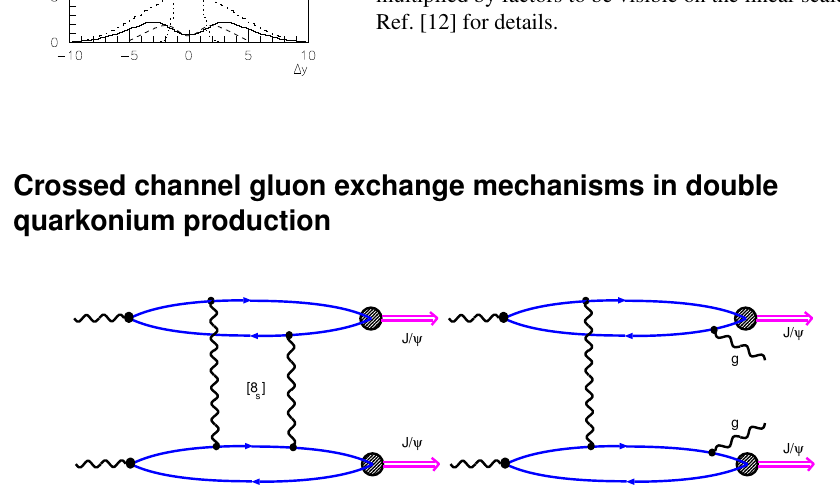
Figure 3. The distribution of rapidity distance ∆ y between J /ψ ’s. Dotted line: the sharp peak predicted by the box-diagrams. Dash-dotted: DPS contribution. The other lines correspond to higher order mechanisms and are multiplied by factors to be visible on the linear scale, see Ref. [12] for details.